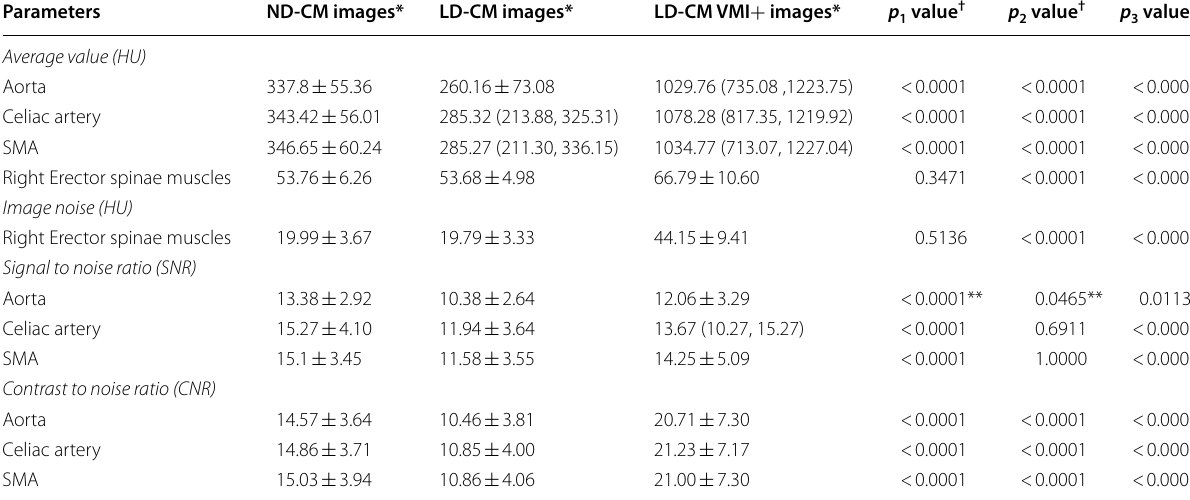
Data are means standard deviations or Median (P25, ±